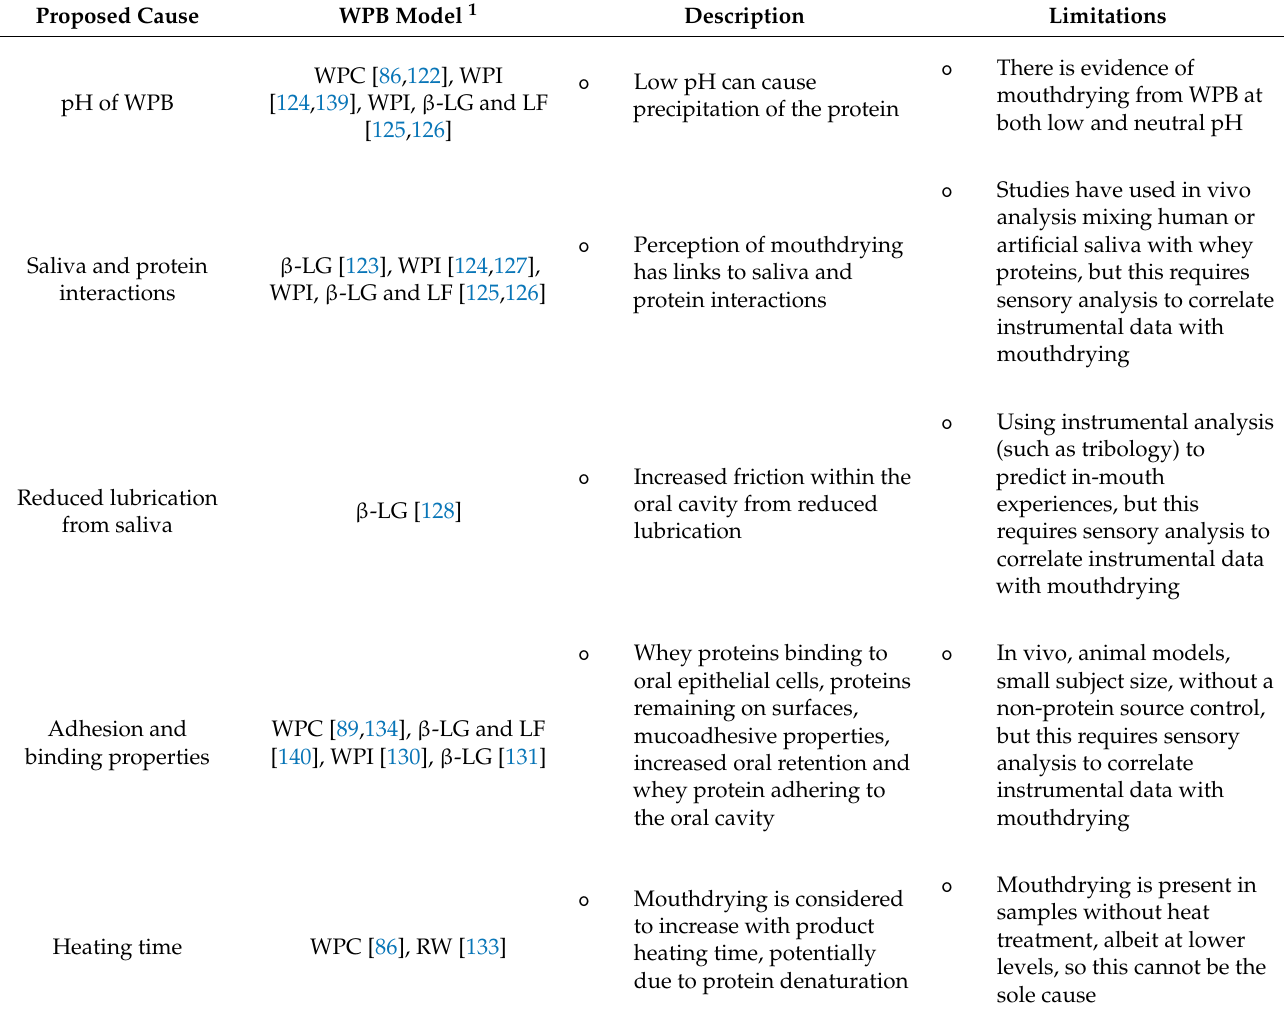
Table 2. Commonly proposed causes of whey protein beverage (WPB) derived mouthdrying adapted from Norton et al. [89] and associated